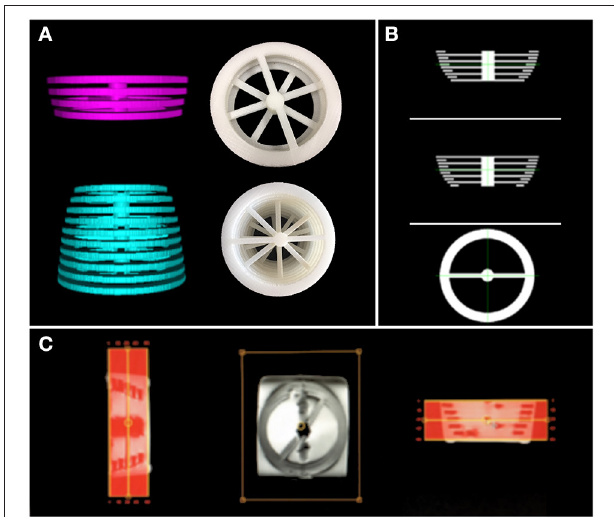
FIGURE 2 | 3D structures used to build the MRI phantoms. In (A) -top, rings representing MHC from 3 to 18 years old; (A) -bottom: rings representing MHC from 0 to 3 years old. In (A) , digital prototypes are shown on the left, while 3D-printed creations are presented in the right. (B) shows the digital designs of the rings in 3 views. (C) is a screenshot of the created MRI phantom obtained from the scanner interface (low resolution). These structures are used to estimate the error induced by the automatic measuring